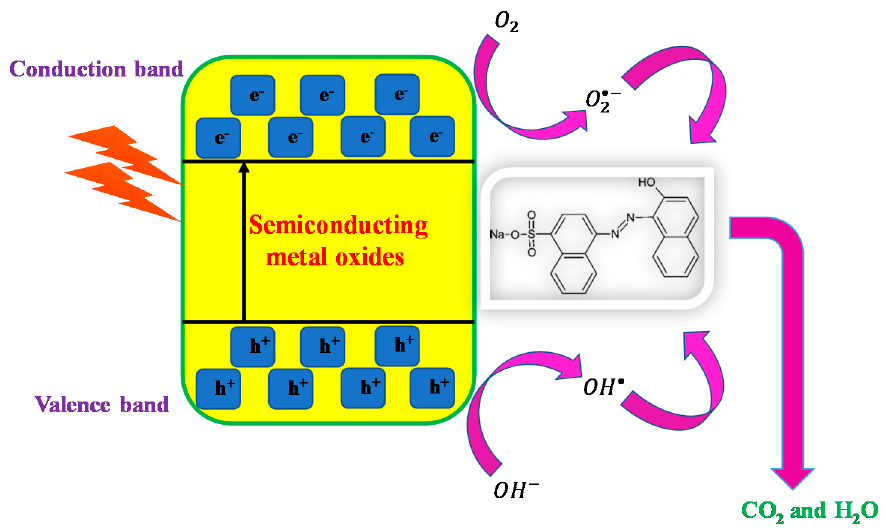
Figure 8. Pictorial representation of possible photocatalytic mechanism.